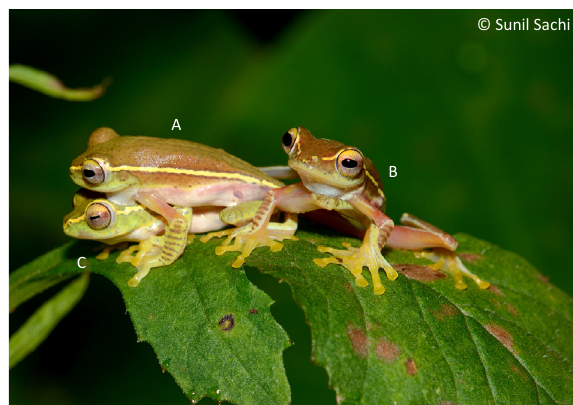
Image 3. Male-male combat in Rhacophorus lateralis